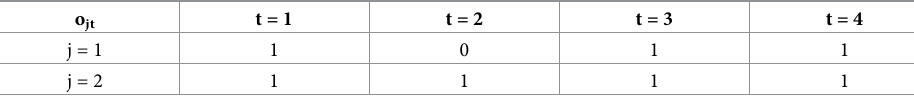
Table 2. The ordering for the suppliers at different periods. o jt